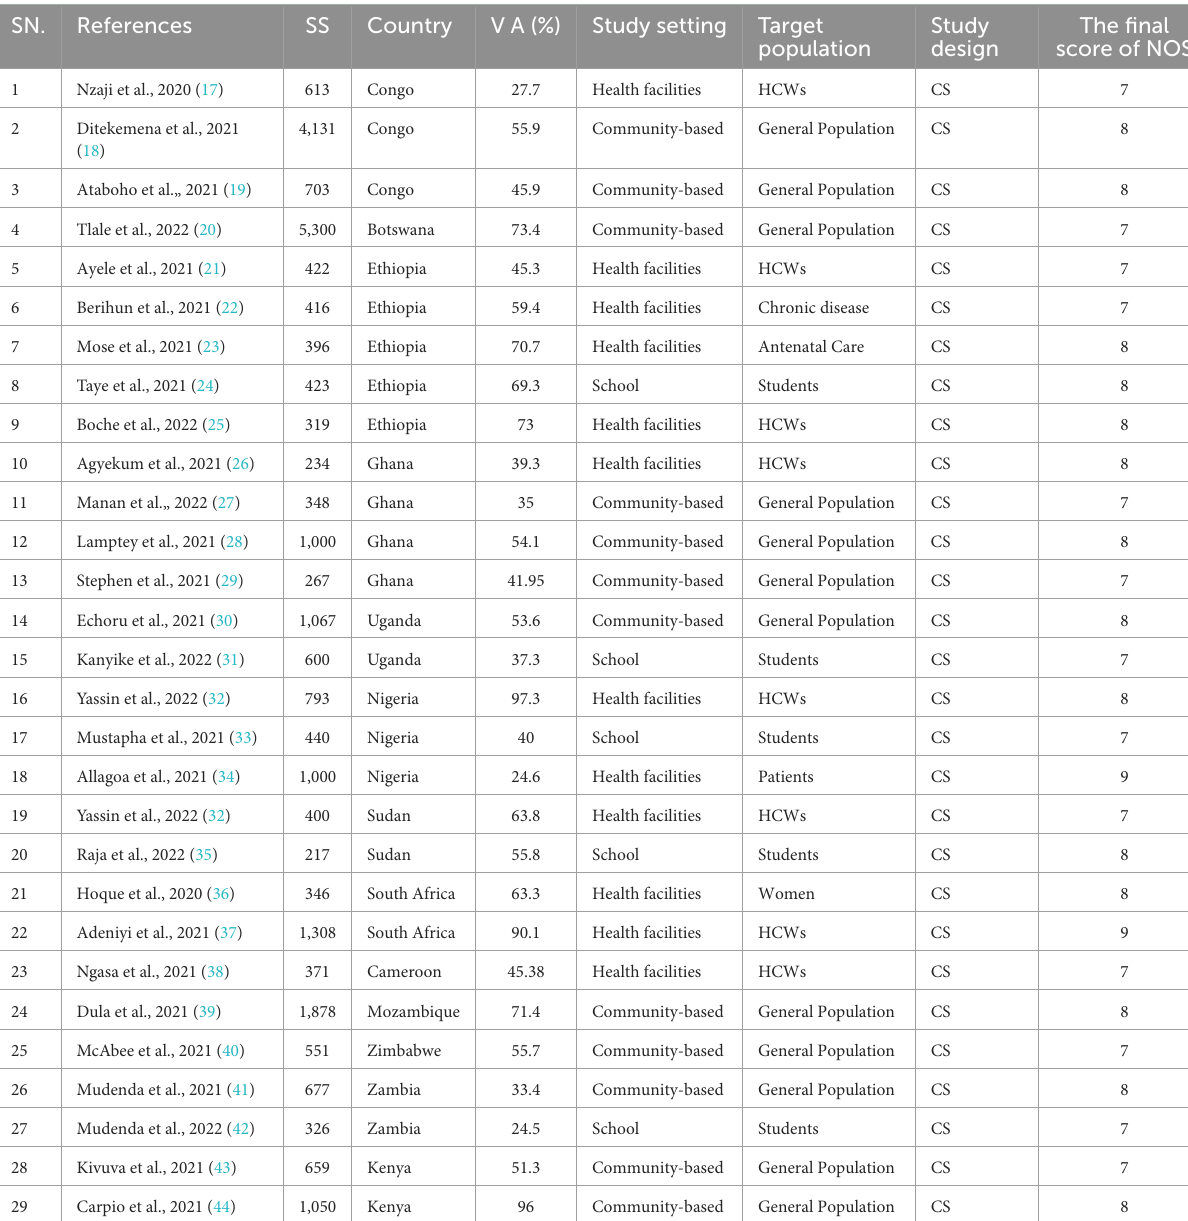
TABLE 1 Characteristics of studies included for the final systematic review and meta-analysis of COVID-19 vaccine acceptance and/or associated factors ( n = 29).